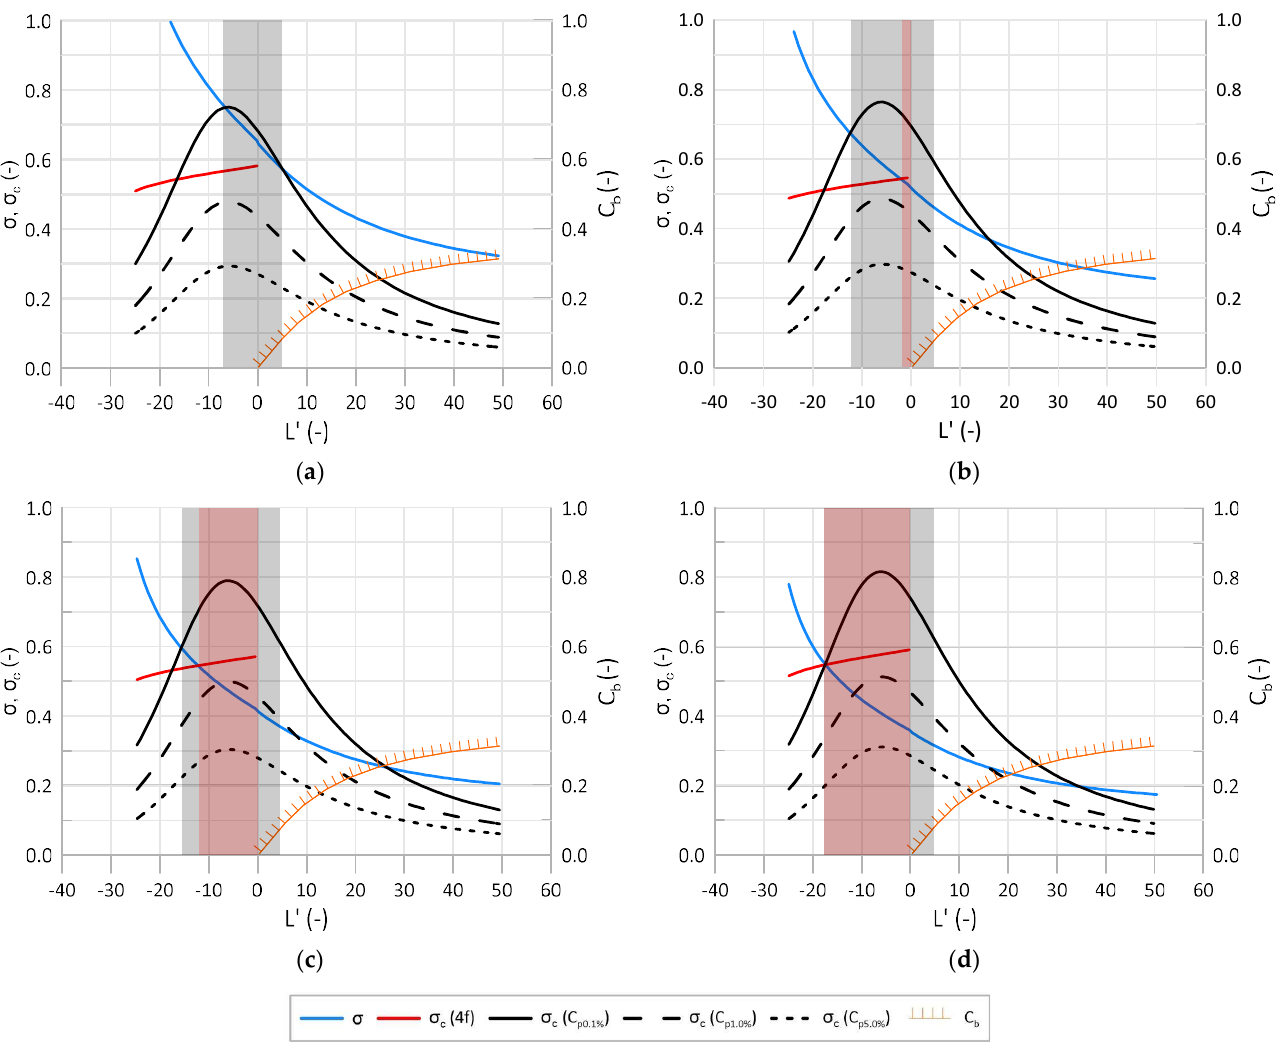
Figure 12. Cavitation index versus critical cavitation index, computed from the C p5.0% , C p1.0% , and C p0.1% extreme pressure coefficients, as well as from the friction factor for the non-aerated flow region: ( a ) h = 0.6 m, q = 15 m 2 /s, d c /h = 4.74; ( b ) h = 0.6 m, q = 20 m 2 /s, d c /h = 5.74; ( c ) h = 0.9 m, q = 30 m 2 /s, d c /h = 5.01; ( d ) h = 1.2 m, q = 40 m 2 /s, d c /h = 4.55.